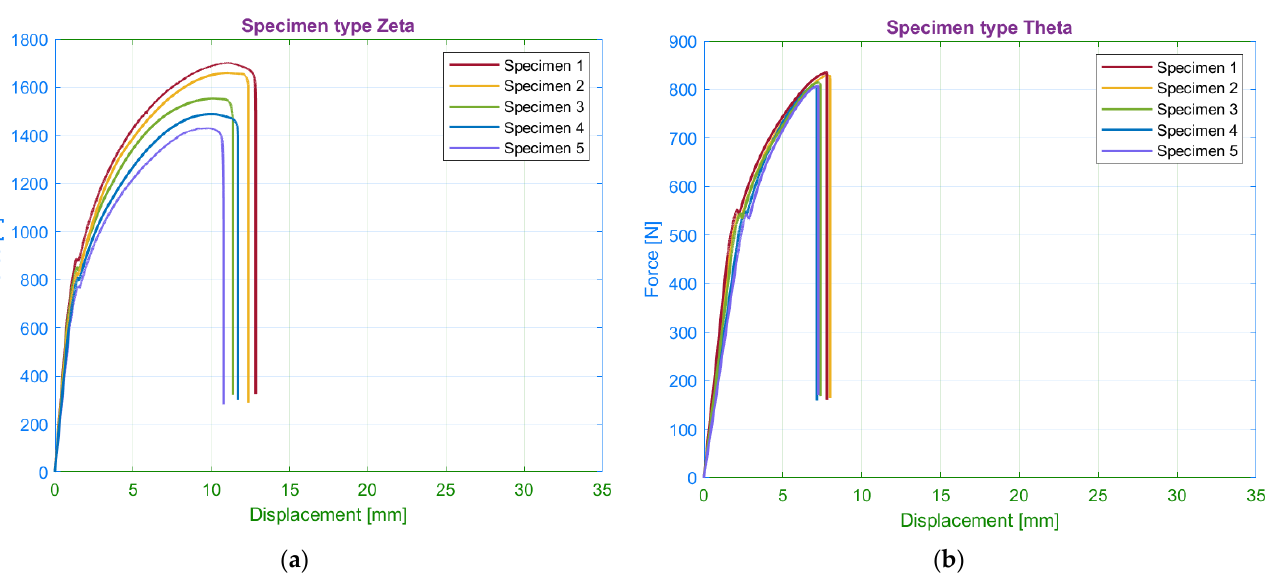
Figure 16 . Tensile diagrams for specimens: ( a ) with 15 walls; ( b ) without walls. Figure 16. Tensile diagrams for specimens: ( a ) with 15 walls; ( b ) without